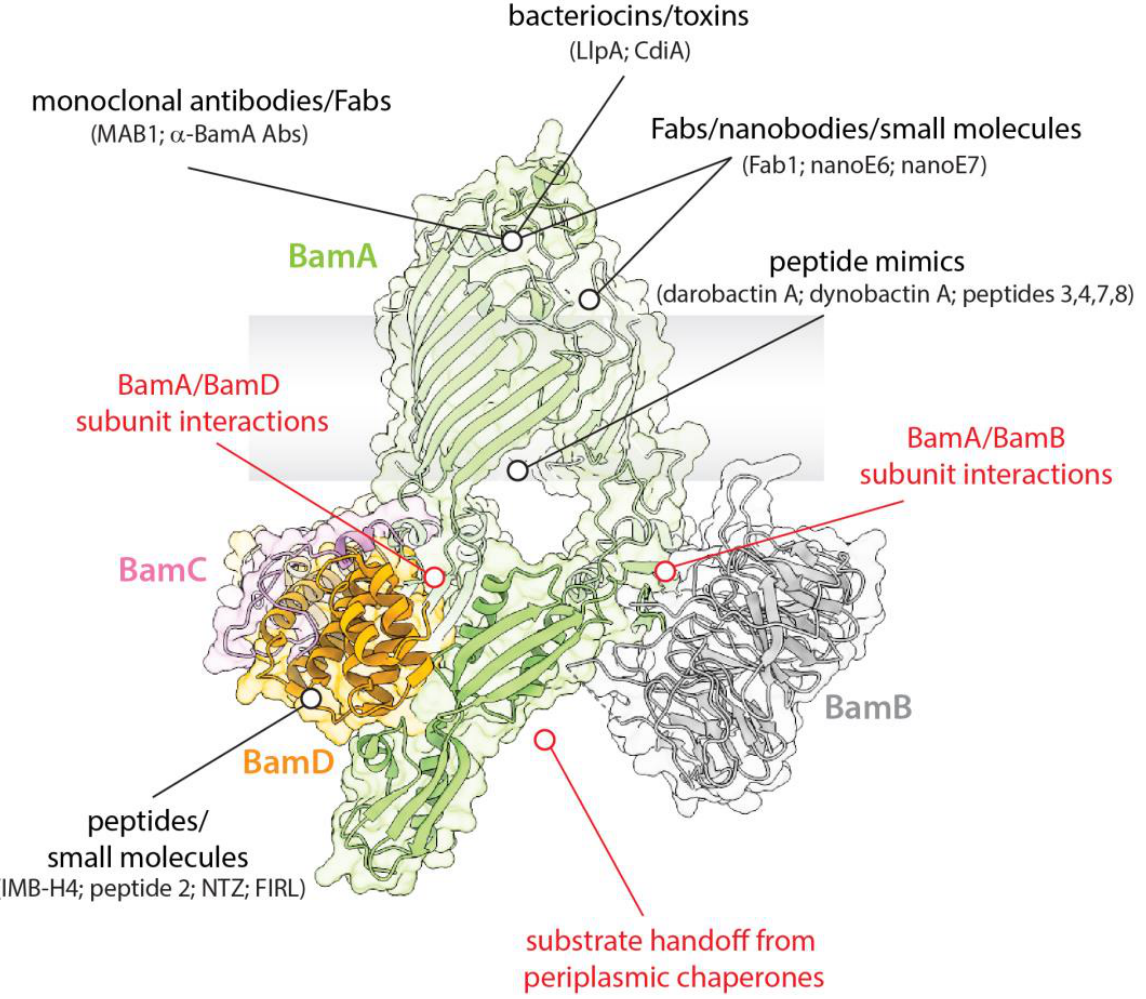
Figure 3. BAM as a promising therapeutic target. The essential role of BAM makes it a promising target for both the development of vaccines and for the discovery of new antibiotics. Regions of BAM that have been successfully targeted are indicated in black, with other interactions that additionally be targeted are indicated in red. Given that BAM is known to be highly dynamic, intermediate states during function would present additional interactions that may also be targeted to disrupt function.